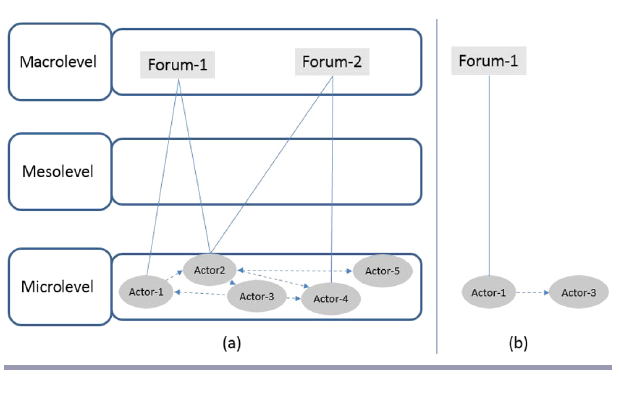
Fig. 1 . Examples of (a) multilevel policy network, and (b) configuration.